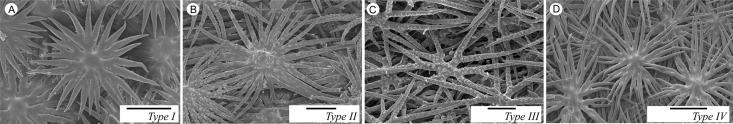
SEM photographs illustrating variation of leaf trichome morphological types in Hormathophylla..
A) Type I: H. cadevalliana. B) Type II: H. lapeyrouseana. C) Type III: H. purpurea. D) Type IV: H. ligustica. Scale bar = 100 μm.